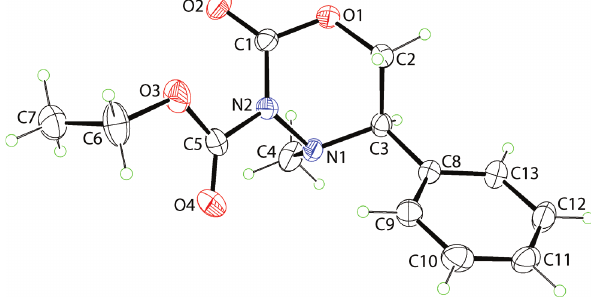
Table 1: Data collection and handling.